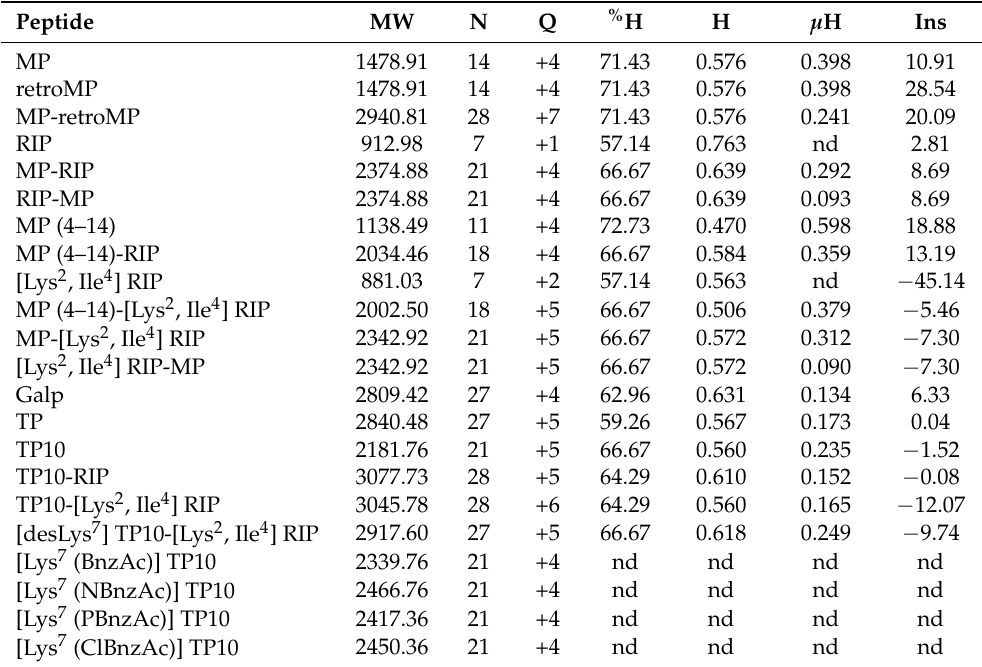
Table 2. The physicochemical properties of synthesized